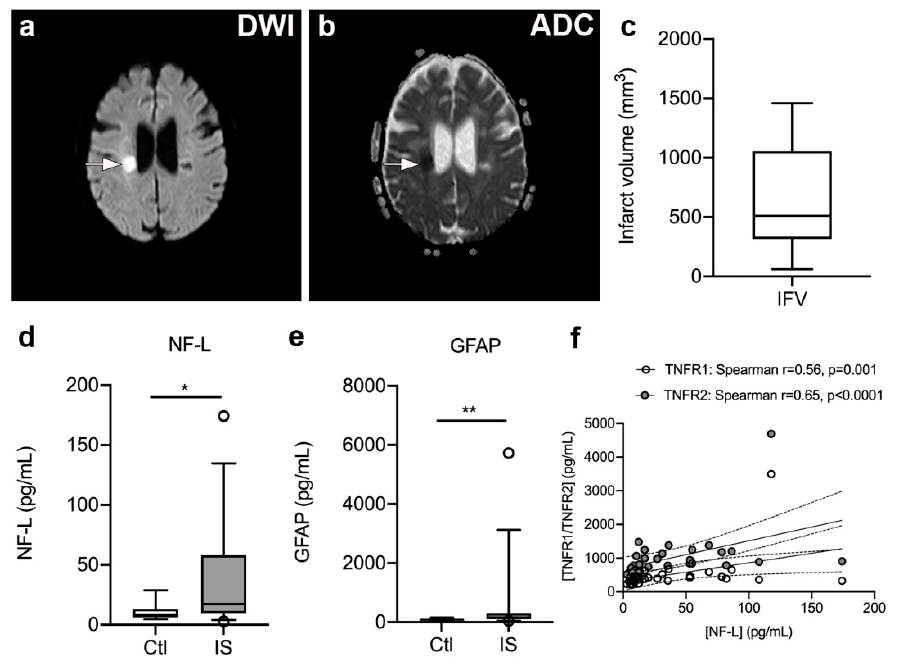
Figure 5. Infarct volumetric analysis in ischemic stroke patients. ( a , b ) Diffusion-weighted imaging (DWI) (a) and apparent diffusion coefficient (ADC) ( b ) images of a subacute ischemic infarct in a 58-year-old woman with a subcortical lacunar infarct in the right hemisphere. ( c ) Volumetric analysis of the size of the infarct obtained on MRI images derived from ischemic stroke patients ( n = 17). ( d , e ) Neurofilament light chain (NF-L) ( d ) and glial fibrillary acidic protein (GFAP) ( e ) concentrations increased significantly in the serum of ischemic stroke (IS) patients ( n = 33) compared to controls (Ctl) ( n = 10). Line: median. Box: 25–75% interquartile range. Whiskers: 5–95% percentile. * p < 0.05, ** p < 0.01. ( f ) Correlation analysis of serum NF-L levels and plasma TNFR1 or TNFR2 levels in IS patients ( n = 33) demonstrating a significant positive correlation between NF-L and TNFR1 or TNFR2 levels post-stroke. Line: linear regression through the data points. Dotted lines: 95% confidence intervals of linear regression.